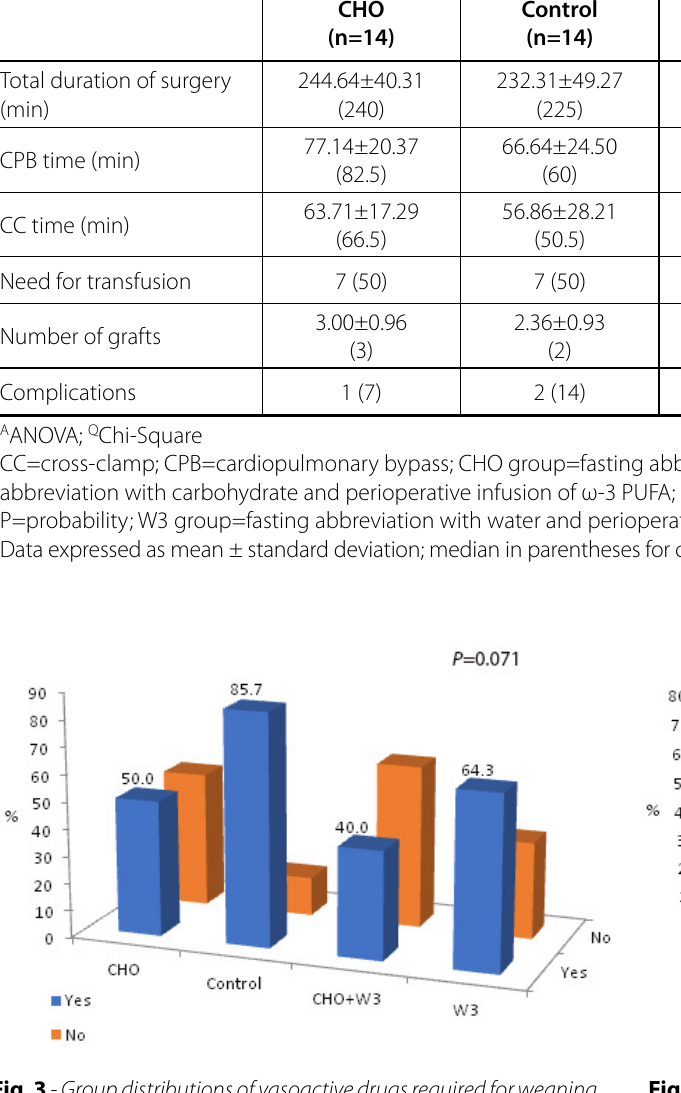
Fig. 4 - Group distributions of vasoactive drugs required during ICU